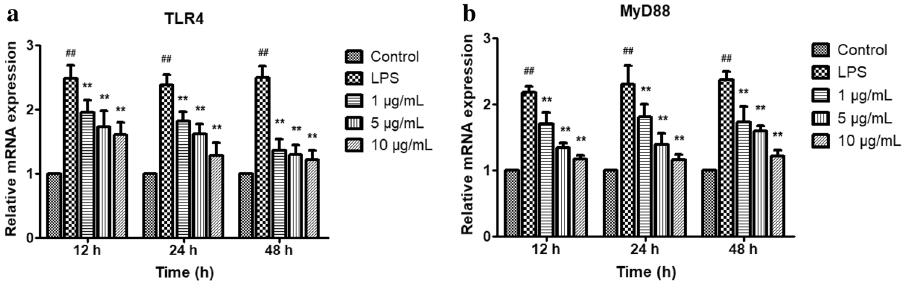
Figure 7. Effect of licochalcone A on LPS-induced mRNA expressions of toll-like receptor 4 (TLR4) ( a ) and myeloid differentiation factor 88 (MyD88) ( b ) in dermal cells. Cells were exposed to gradient concentrations of licochalcone A (1, 5, 10 μg/mL) with or without the presence of 10 μg/mL LPS for 12, 24, and 48 h respectively. The gene expressions of TLR4 and MyD88 were quantified using PCR analysis. The data were presented as mean ± SEM (n = 6). ## P < 0.01 vs. control group; * P < 0.05 vs. LPS model group; ** P < 0.01 vs. LPS model